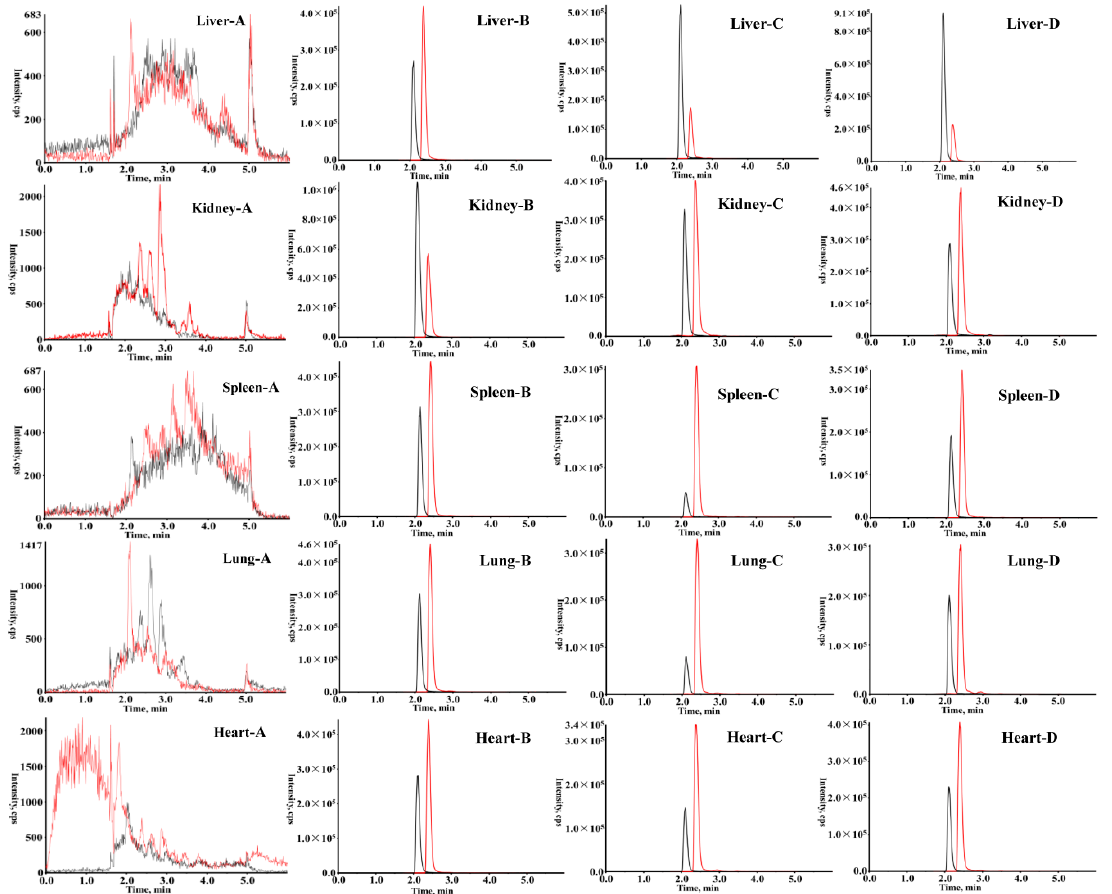
Figure 1. Chromatograms of HCPT and CPT: Blank tissue ( A ). Blank tissue spiked with HCPT and CPT ( B ). Tissue sample after intravenous administration of HCPT at 60 min ( C ). Tissue sample after administration of HCPT and JGGC extract at 60 min ( D ).